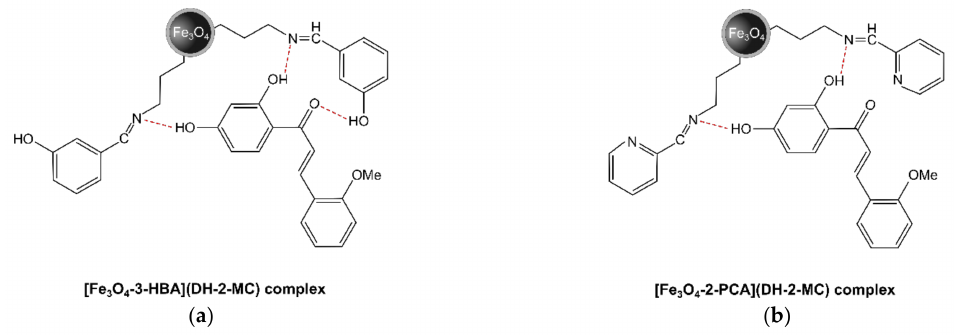
Figure 6. The proposed structures of complexes formed by hydrogen bonds (red dotted lines) between DH-2-MC and the hybrid materials containing Schiff base residues: ( a ) 3-HBA and ( b )